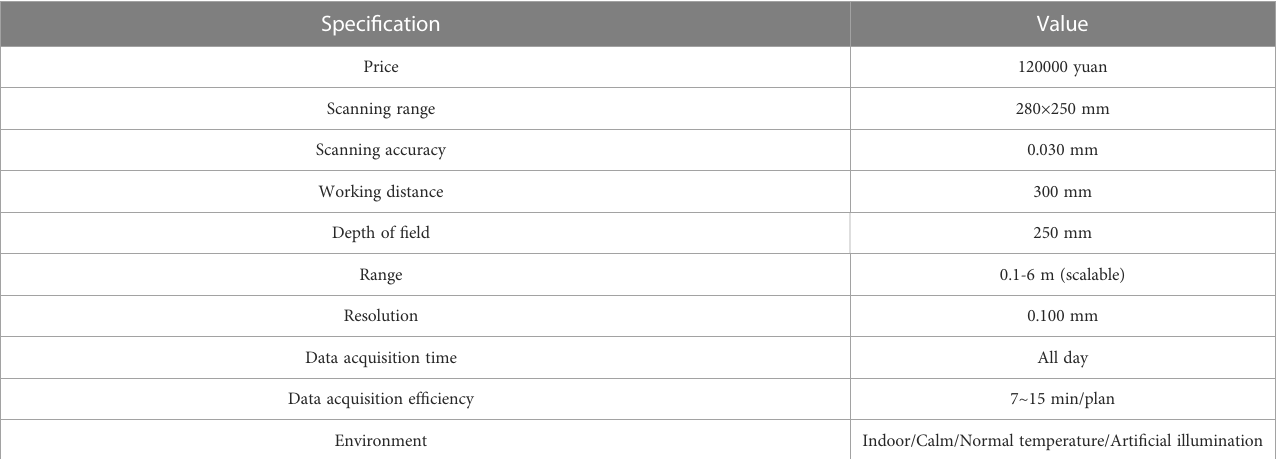
TABLE 2 General speci fi cation of FreeScan laser